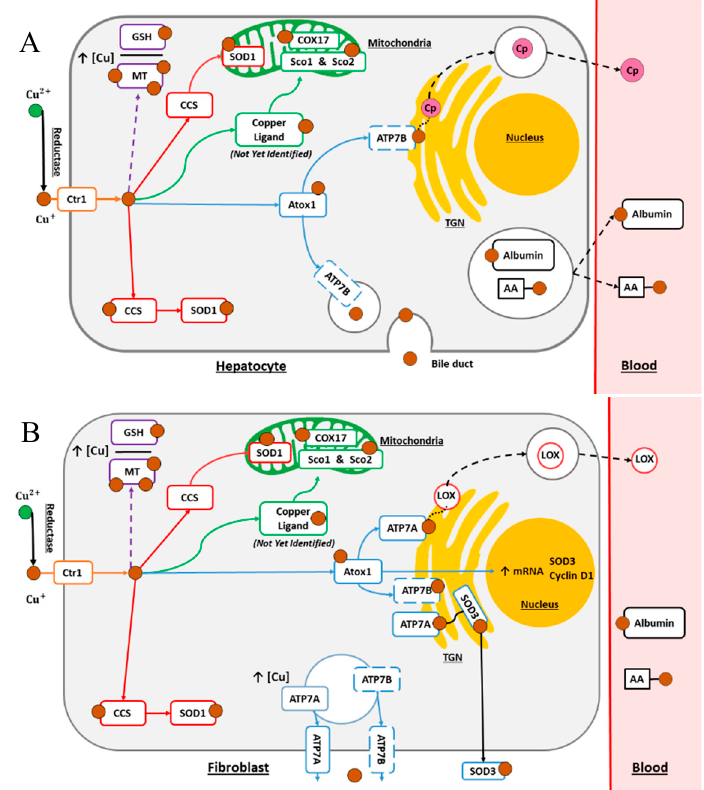
Figure 1. Cellular copper homeostasis in hepatocytes ( A ) and fibroblasts ( B ). In cells, the internalization of reduced Cu occurs via Ctr1. Then, Cu is involved in the control of oxidative stress (red arrows) through a copper chaperone for superoxide dismutase protein (CCS) and cytoplasmic Cu/Zn superoxide dismutase 1 (SOD1). Copper can be stored in its main storage reservoir, the mitochondria, where the proteins COX17, Sco1, and Sco2 play a role in its incorporation into complex IV of the respiratory chain (green arrows). Nevertheless, in the mitochondrial pathway, the identity of the chaperone that carries Cu across the mitochondrial membranes is not clearly identified. The excess Cu can also be sequestered by metallothioneins (MT) and/or bound by glutathione (GSH; dashed purple arrows). ( A ) In hepatocytes, copper can be secreted via the bile duct or released in the blood stream bound to ceruloplasmin (Cp) after transport by Atox1 and ATP7B proteins (blue arrows) and transit in the trans-Golgi network (TGN). Cu is released into the blood stream and travels by binding to Cp, amino acids (AA), or albumin. ( B ) In fibroblasts, ATP7A carries Cu from Atox1 to the TGN for its integration into lysyl oxidase (LOX) or extracellular superoxide dismutase 3 (SOD3) before their extracellular release. In addition, the excess intracellular Cu can be removed from the cell through ATP7A and ATP7B.